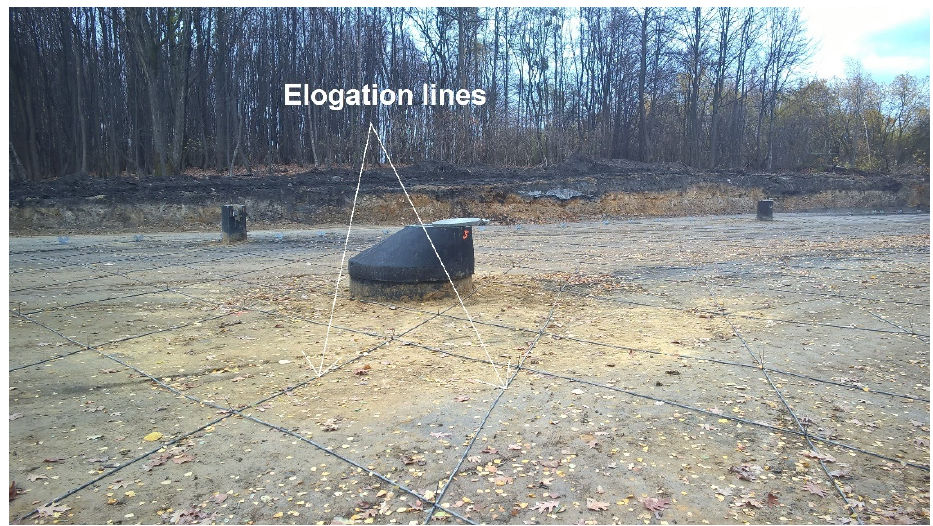
Figure 3. First monitoring layer, measurement of subsidence through elongation links mounted to string sensors—Ruda ´Sl ˛aska, N–S route, Poland 2018 (example of monitoring application).